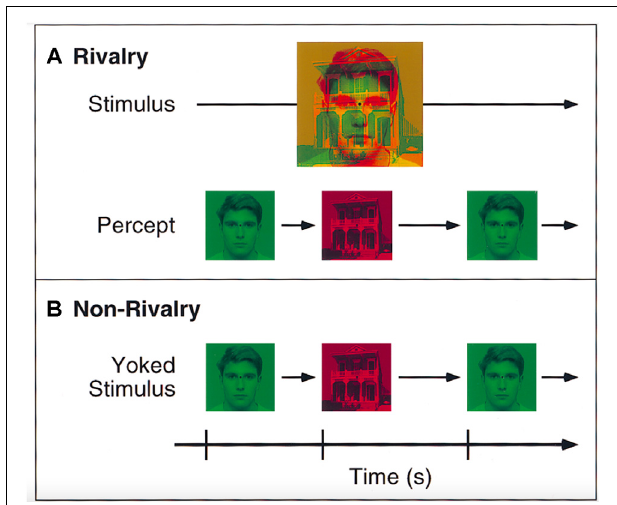
FIGURE 1 | Illustration of the Binocular Rivalry task. (A) Depiction of two different stimuli (i.e., face and house). Each is presented simultaneously to one eye, which leads to binocular rivalry as indicated by differences in perception. (B) In contrast, illustration of a yoked stimulus (each stimulus is matched to the rivalry condition). This condition involves the presentation of the same stimuli consecutively without rivalry. Reprinted with permission from the publisher of “Binocular Rivalry and Visual Awareness in Human Extrastriate Cortex” by Tong et al. (1998). Copyright (1998) by Cell